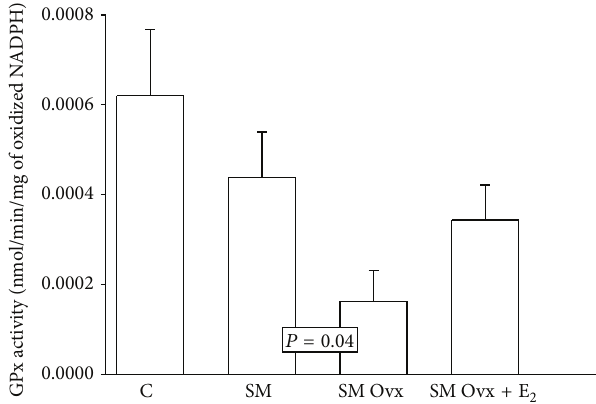
Figure 4: Effect of the ovariectomy and estradiol replacement on glutathione peroxidase activity in the adipocyte homogenate. Data are means ± SE; 𝑛 = 8 each